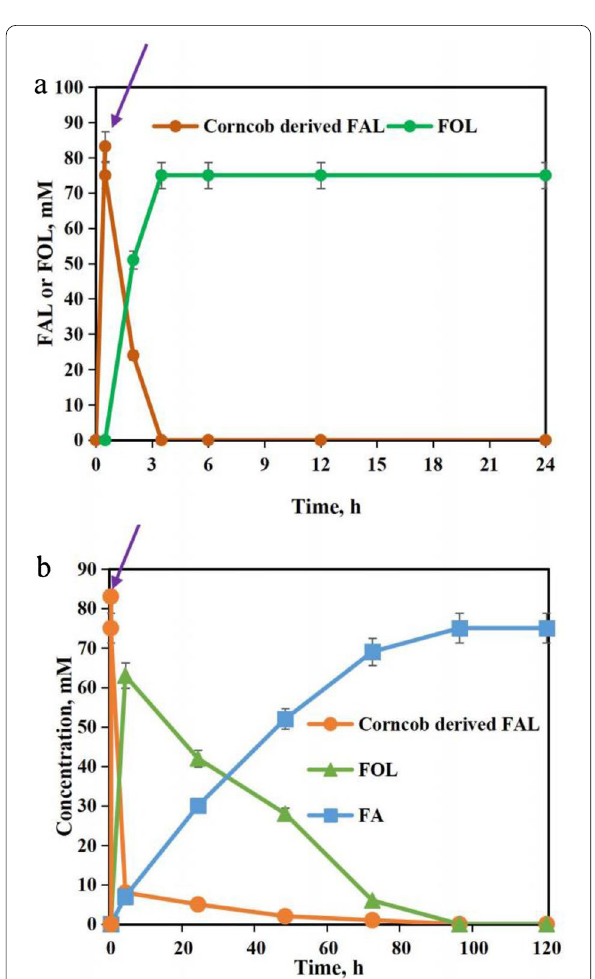
Fig. 5 Reaction process for one‑pot production of FOL ( a ) and FA ( b ) from corn cobs catalyzed by chemoenzymatic cascade catalysis with maleic acid‑assisted Sn‑GP chemocatalyst and whole‑cell biocatalyst. (Arrow: pH